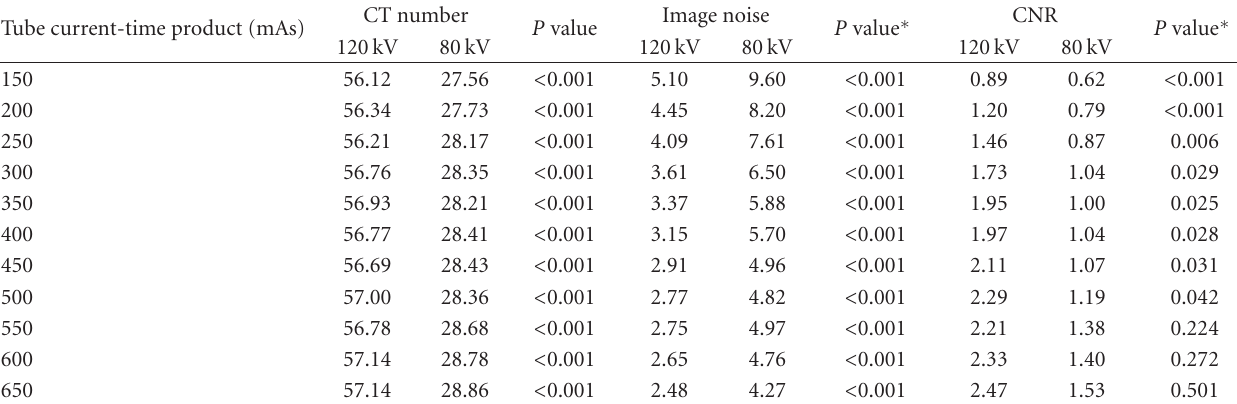
Table 2: The CT numbers, image noise, and CNR obtained at each set of acquisition conditions.